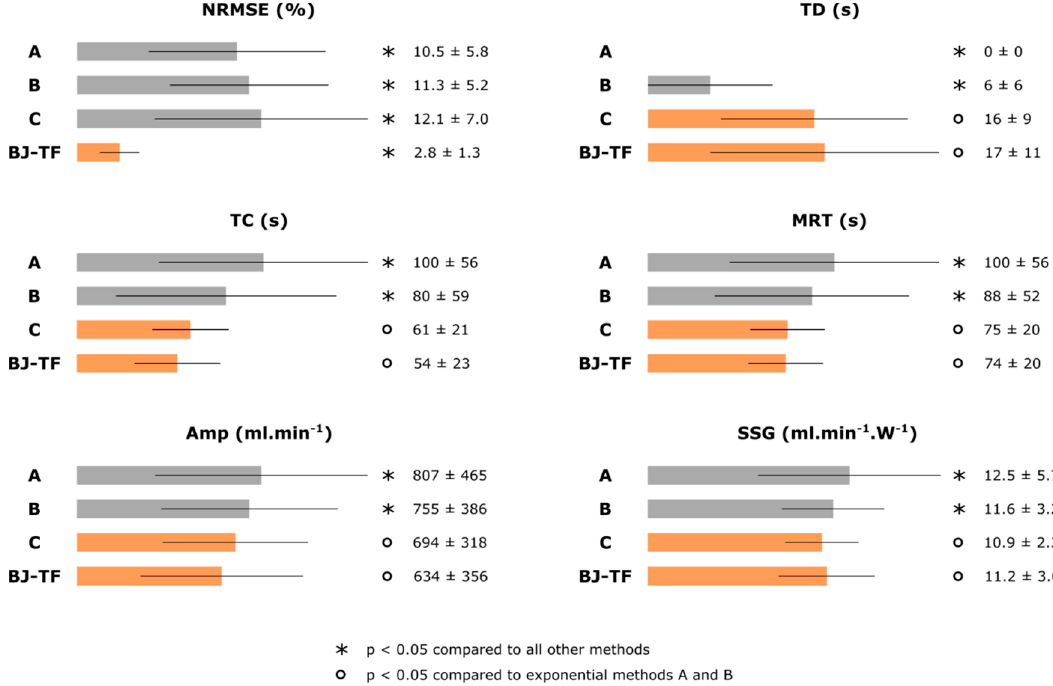
Figure 5. NRMSE and kinetic feature values summarised as median (bar) and interquartile range (line) for exponential modelling methods A, B, C and the BJ-TF model with noise model order [2 0].